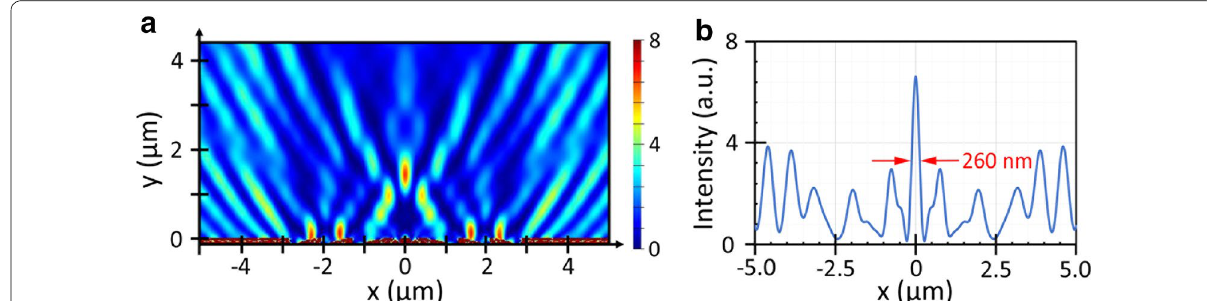
Fig. 6 Beam focusing effects of an all-dielectric (Si/silica) slanted-nanoslit-array nanolens. a FDTD simulation of transmission pattern simulated at 633 nm wavelength. The same structure and dimensions are assumed as the Ag lens case (Fig. 3). b The intensity profile scanned at the focal